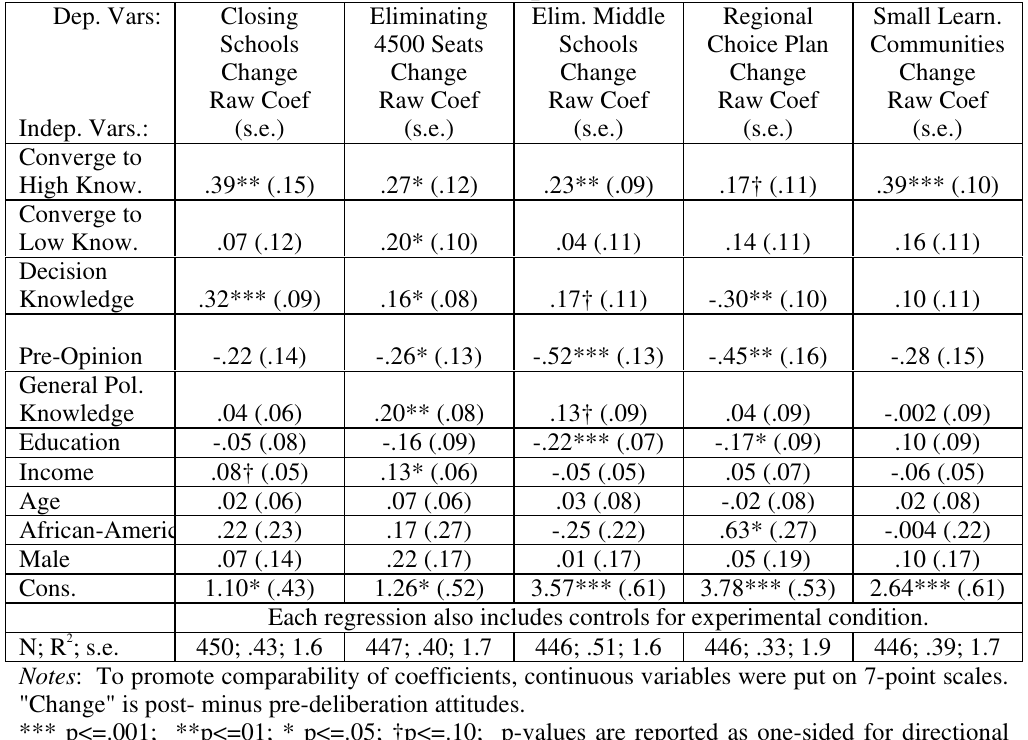
Table 1: Effects of Decision Knowledge on Policy Attitude Change and on Other's